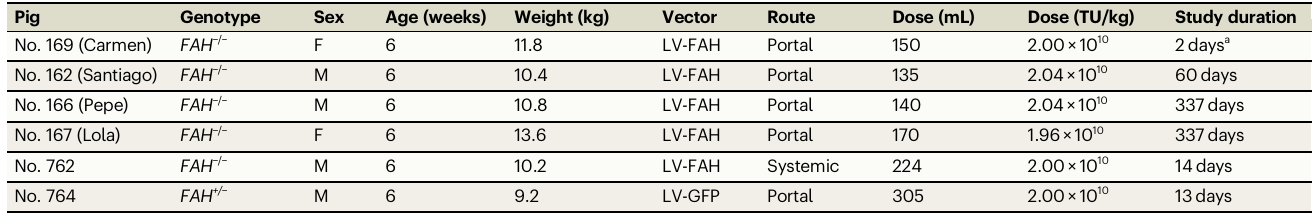
Table 1 | Gene therapy dose in treated